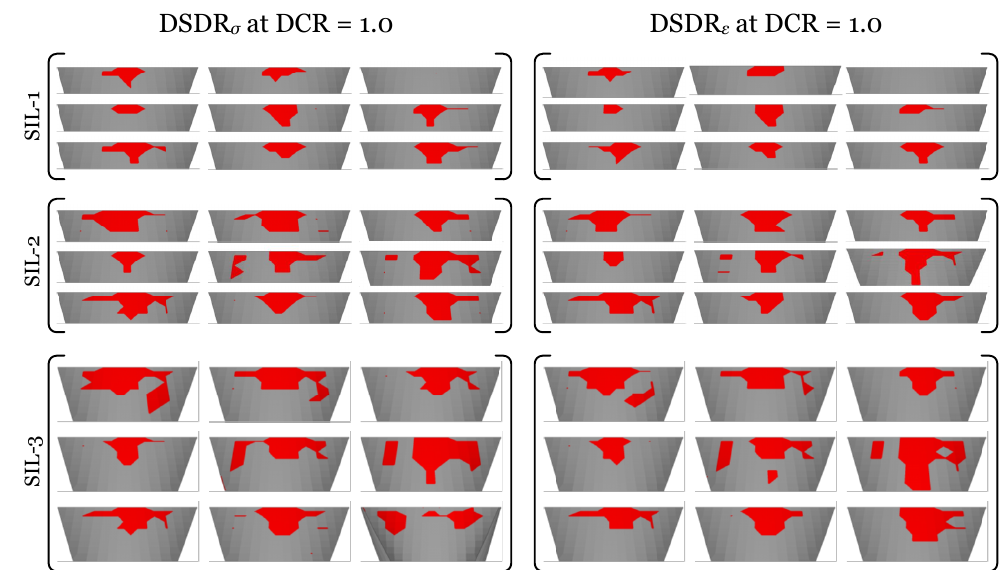
Figure A1. Matrix of over-stress and over-strain area on Dam-1 upstream face; Note: Each matrix includes 9 plots associated with 9 ground motions. In each matrix, top-left to bottom-right are #1 to